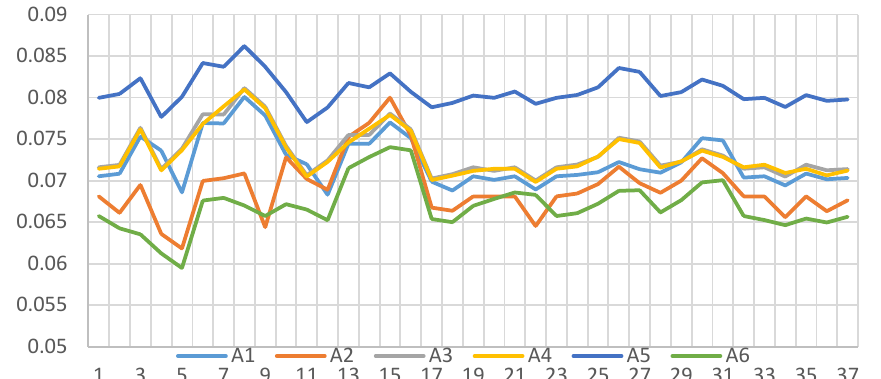
Figure 3. Sensitivity analysis diagram for different weighting scenarios in fuzzy TOPSIS Fig 3 - Sensitivity analysis diagram for different weighting scenarios in fuzzy